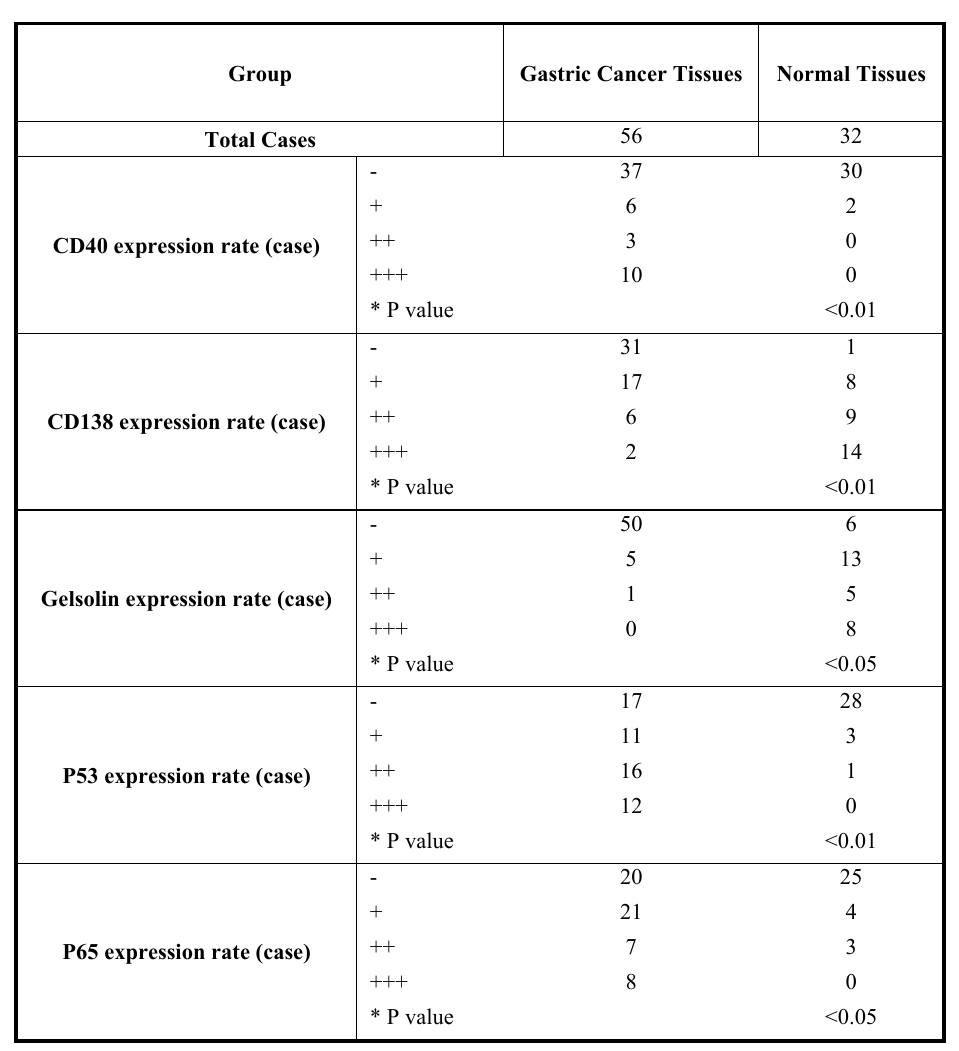
Table 1. Expression of CD40, CD138, Gelsolin, P53 and P65 in gastric cancer and normal